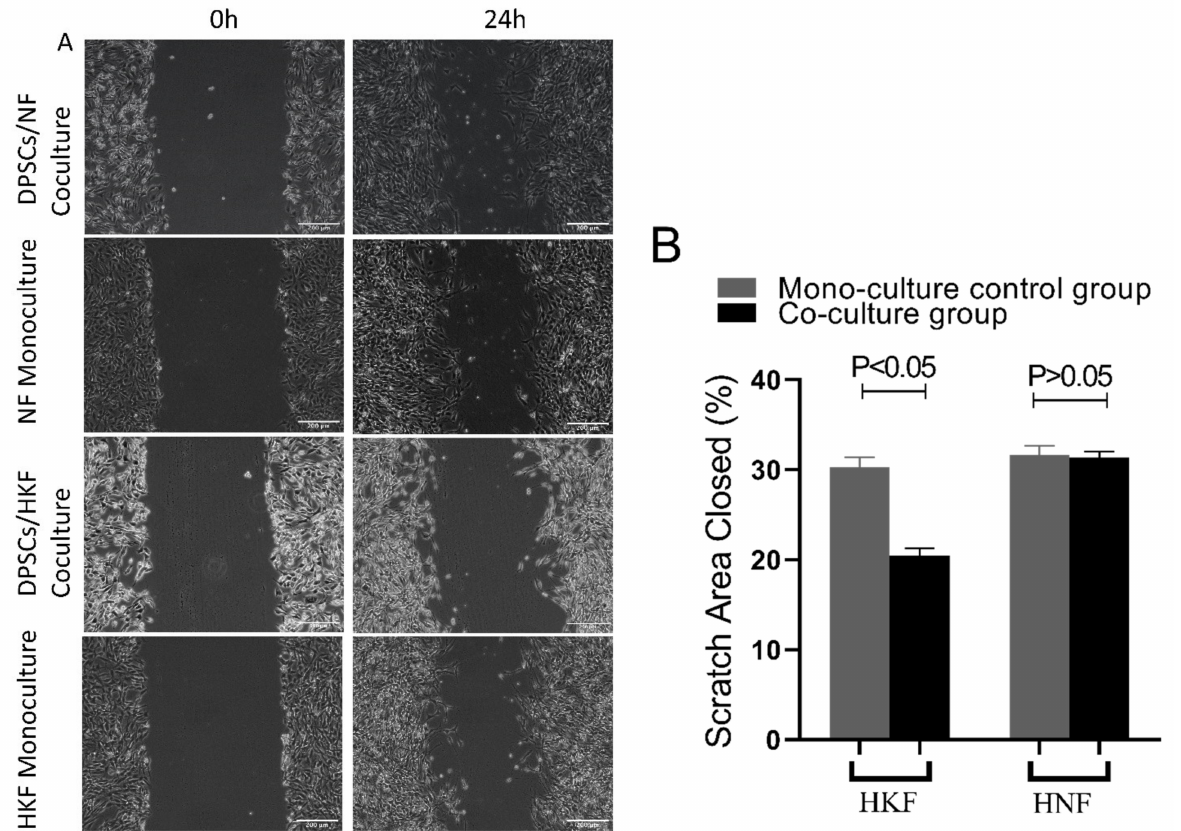
Figure 6. Cellular migration in scratch area. ( A ): Pictures were taken at 0 and 24h, a magnification of 100 × was used. ( B ): Percentage of wound area recovery by migrated cells was quantified by Image J. Significant differences were only detected in the co-culture group of the human keloid fibroblast after 24 h ( p < 0.05, t -test; n = 7, mean ±